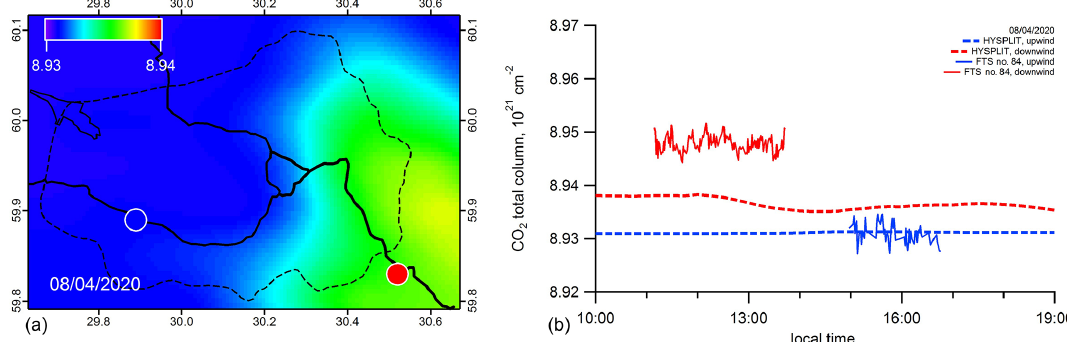
Figure 9. (a) Urban pollution CO 2 plume over St Petersburg calculated by the HYSPLIT model for 8 April 2020 (10:00UTC). The colour bar designates the CO 2 total column in units 10 21 cm − 2 . The blue and red circles indicate the locations of upwind and downwind FTS observations, accordingly. (b) Time series of measured (FTS) and simulated (HYSPLIT; without scaling of the ODIAC emissions data) CO 2 total column at the upwind (blue lines) and downwind (red lines) locations for the same day.